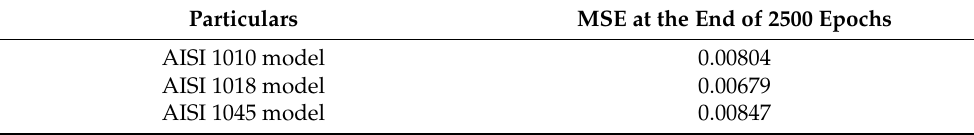
Table 4. Mean square error (MSE) for different AISI grades